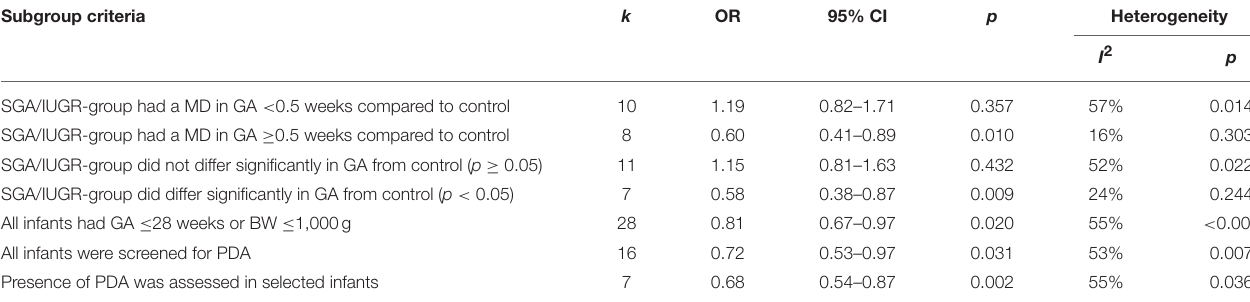
TABLE 2 | Subgroup analyses. Subgroup criteria